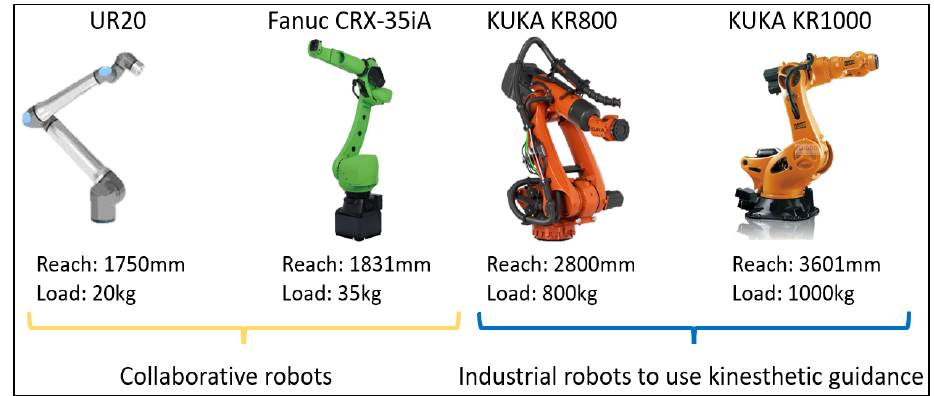
Figure 1. Comparison of collaborative robotic arms and industrial manipulators in terms of reacha- bility and load capacity [14 – 16]. These industrial arms can support the kinesthetics concept for path planning , transforming these robots into collaborative entities .